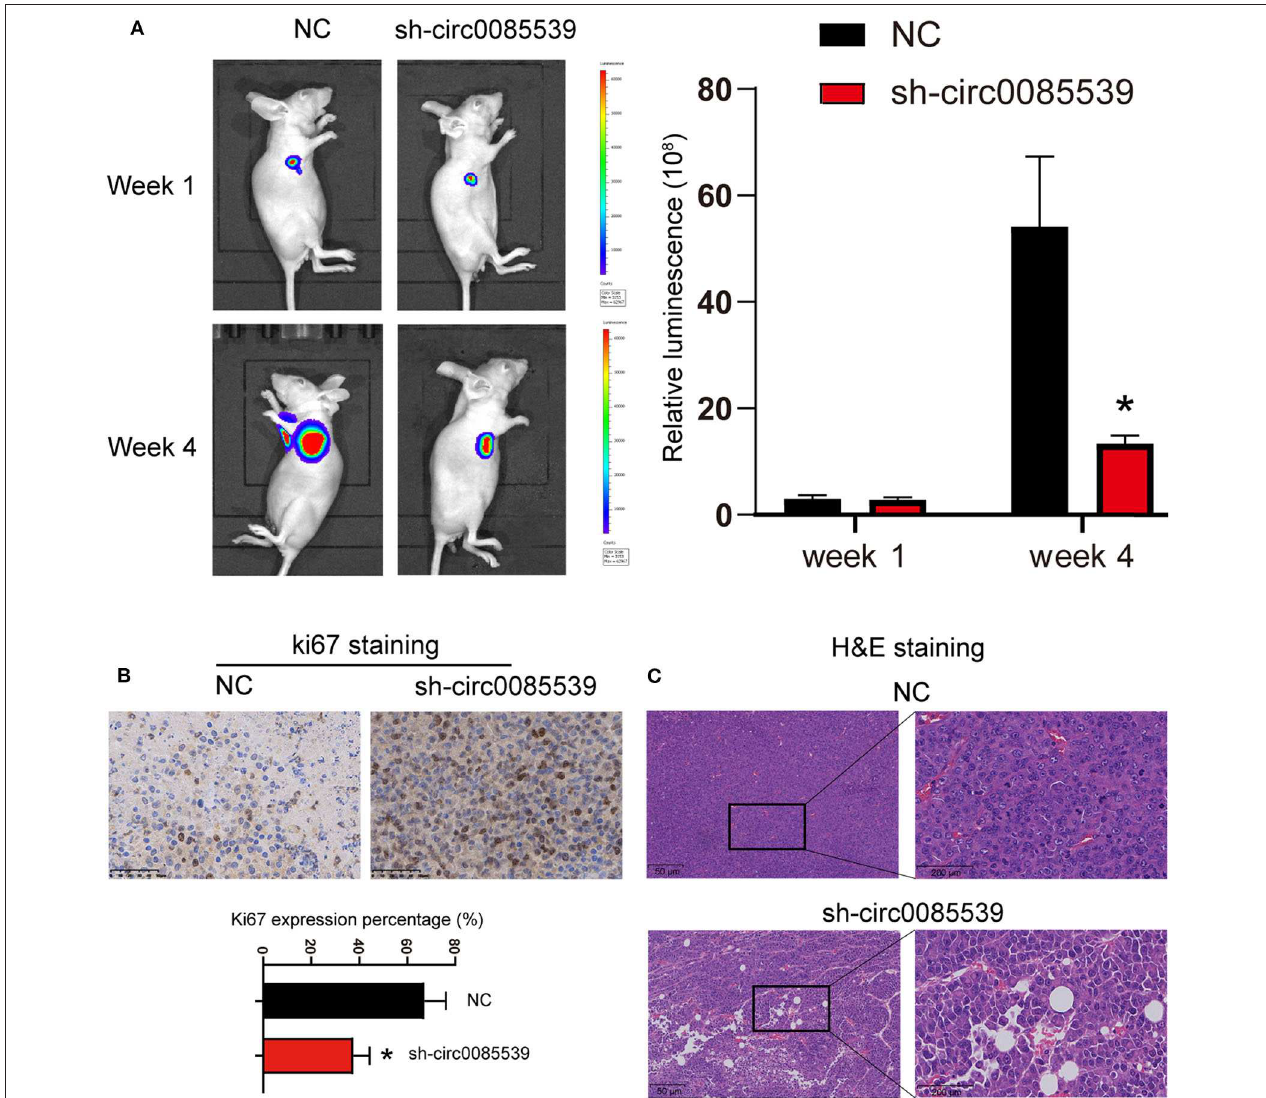
FIGURE 2 | Silencing circ0085539 inhibited tumor growth in vivo ( n = 6 each group). (A) Live imaging of the effects of circ0085539 knockdown on osteosarcoma growth in vivo . The luminescence was analyzed. (B) Ki67 staining and (C) H and E staining of xenografted tumor tissues with the knockdown of circ0085539 compared with the negative control (sh-NC) group. Scale bar for Ki67 IHC, 50 µ m; scale bar for HandE, 50 µ m (left panel) and 200 µ m (right panel). * p < 0.05 vs.